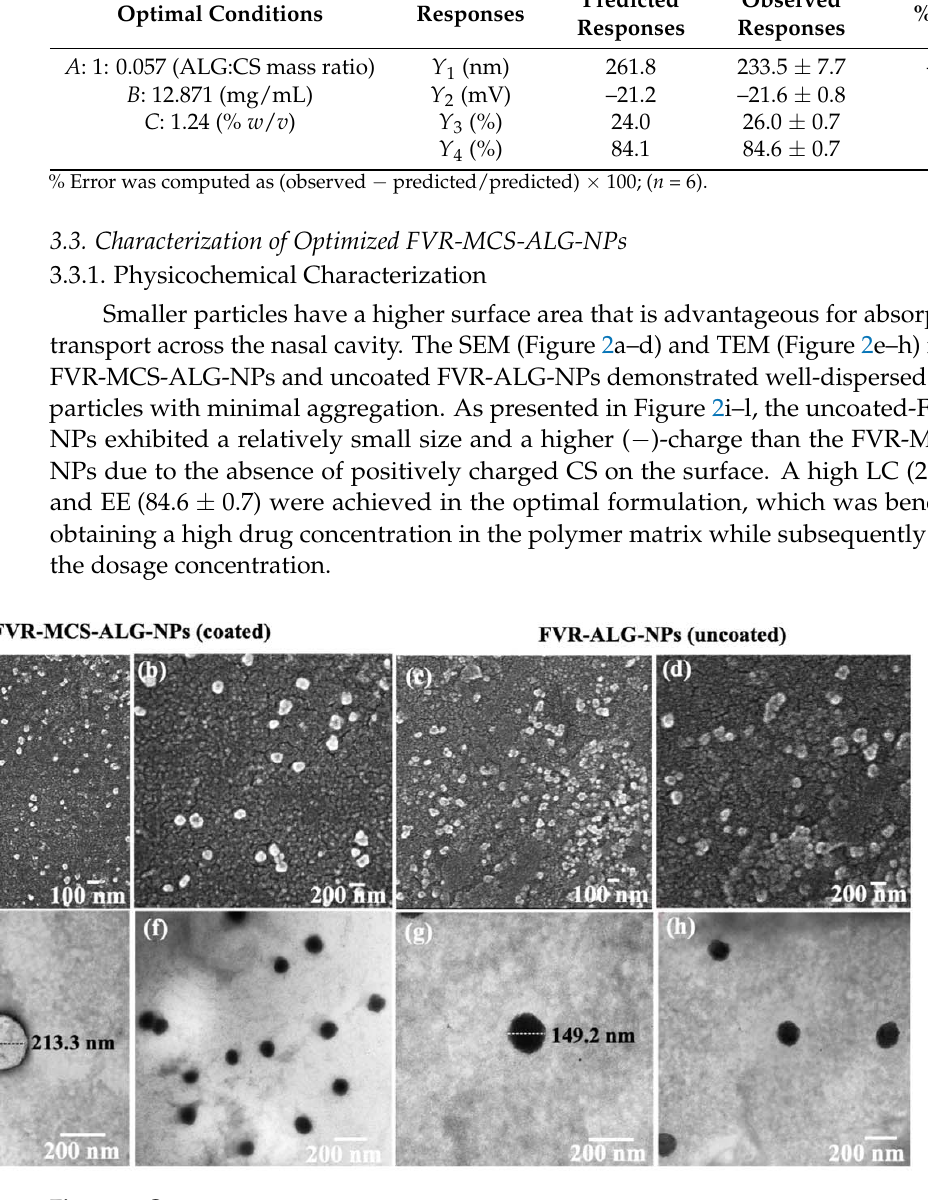
Table 3. The compositions and values of optimal conditions and their predicted and observed responses. Optimal Conditions Responses